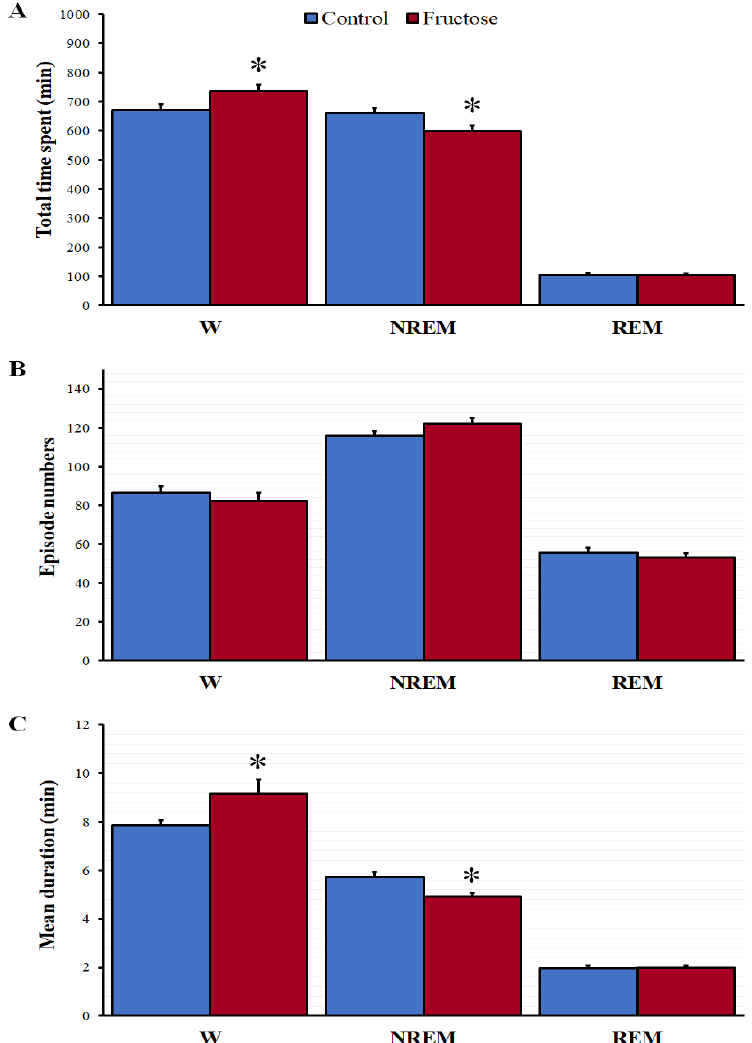
Figure 1. Fructose consumption modifies the sleep-wake cycle of the rat. Total time spent ( A ), number of episodes ( B ), and mean duration ( C ) of each stage following the tap water or 10% fructose ingestion for five weeks. Results are expressed as mean ± SEM, N = 9–10 per group. The differences between the groups were analyzed with t -test (* p < 0.05 vs. control group). W: wakefulness; NREM: non-rapid eye movement; REM: rapid eye movement.